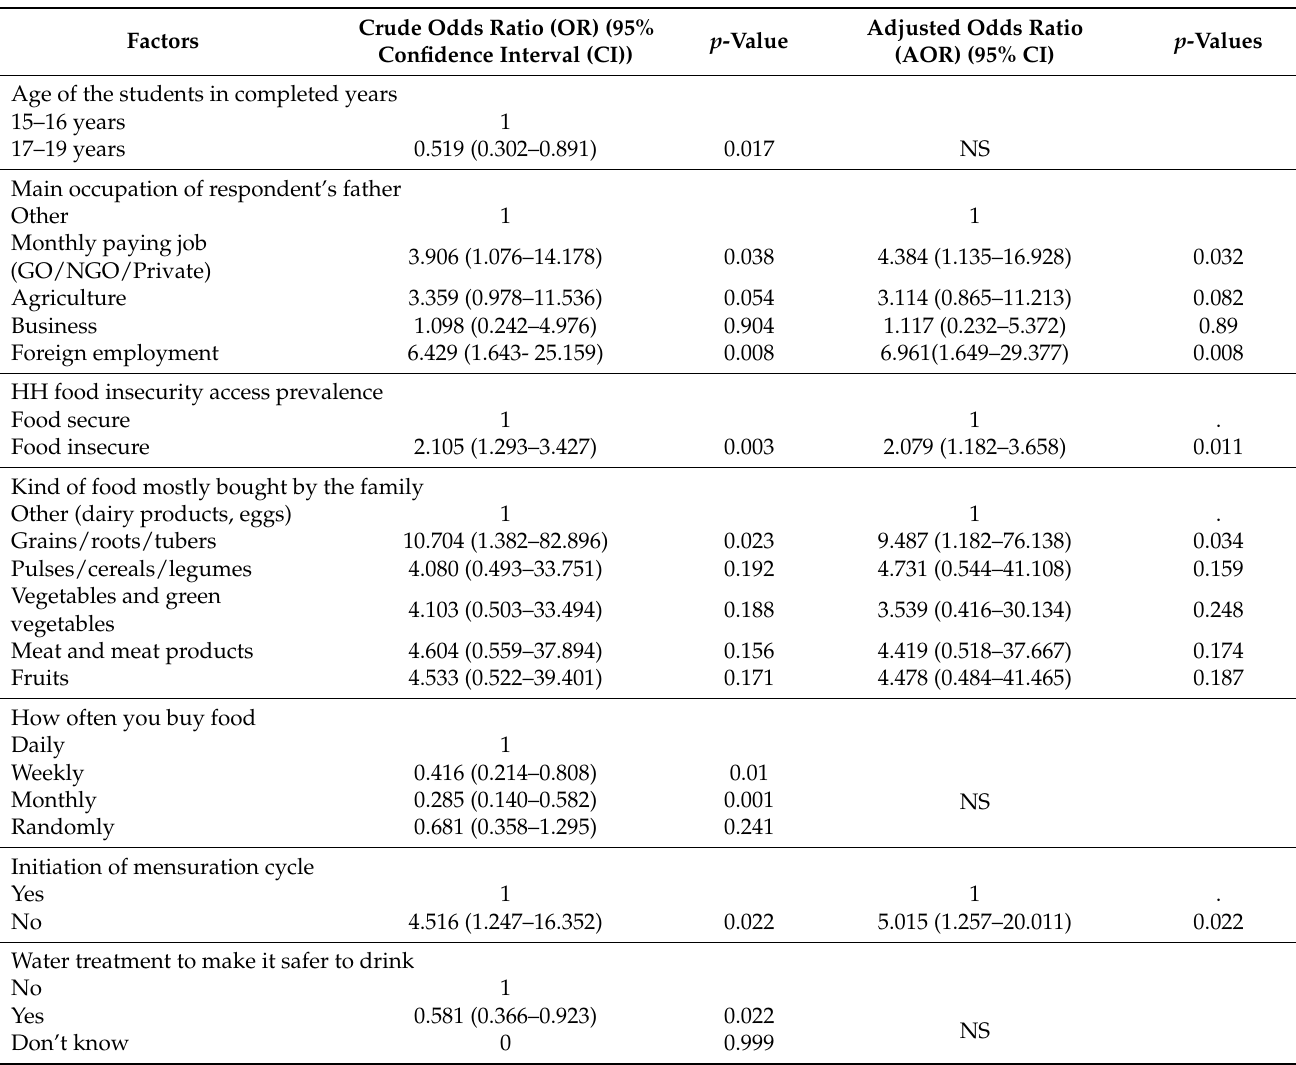
Table 7. Factors associated with low BMI